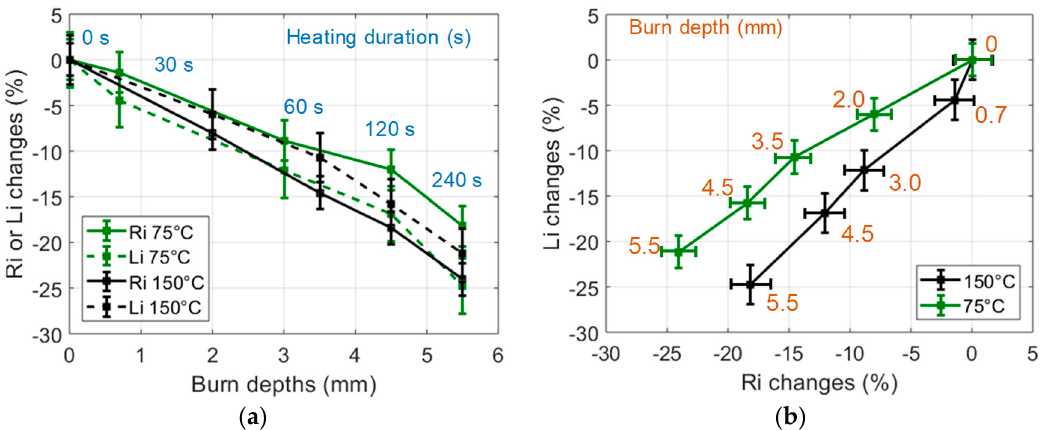
Figure 8. ( a ) Changes of the dielectric properties of 75 ◦ C and 150 ◦ C IHP-samples expressed in % vs